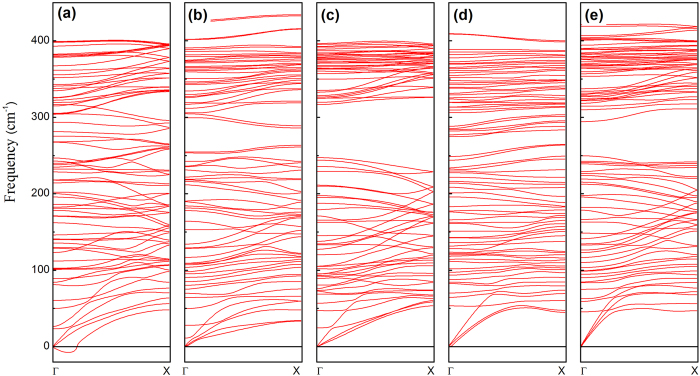
Calculated phonon dispersions of (a) 6-TPNR, (b) 6-TPNRrec (c) 6-TPNRH (c) 6-TPNRO and (d) 6-TPNRF.